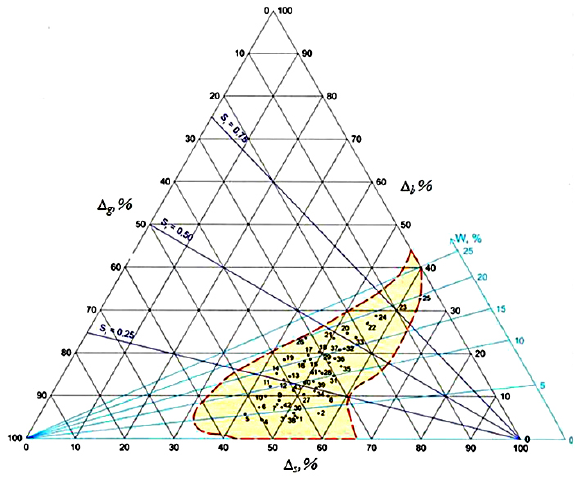
Fig. 3. Diagram of phase composition of sand with the numbers of control points: the dotted line is an area of possible correla- tion of phases in this soil; W is gravimetric humidity; S r is a humidity